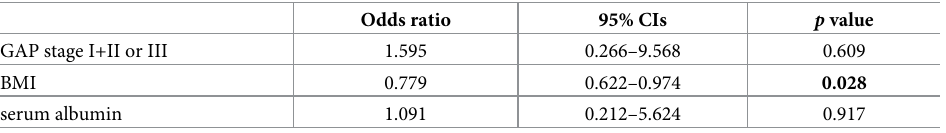
Table 4. Multivariate logistic regression analysis for any adverse